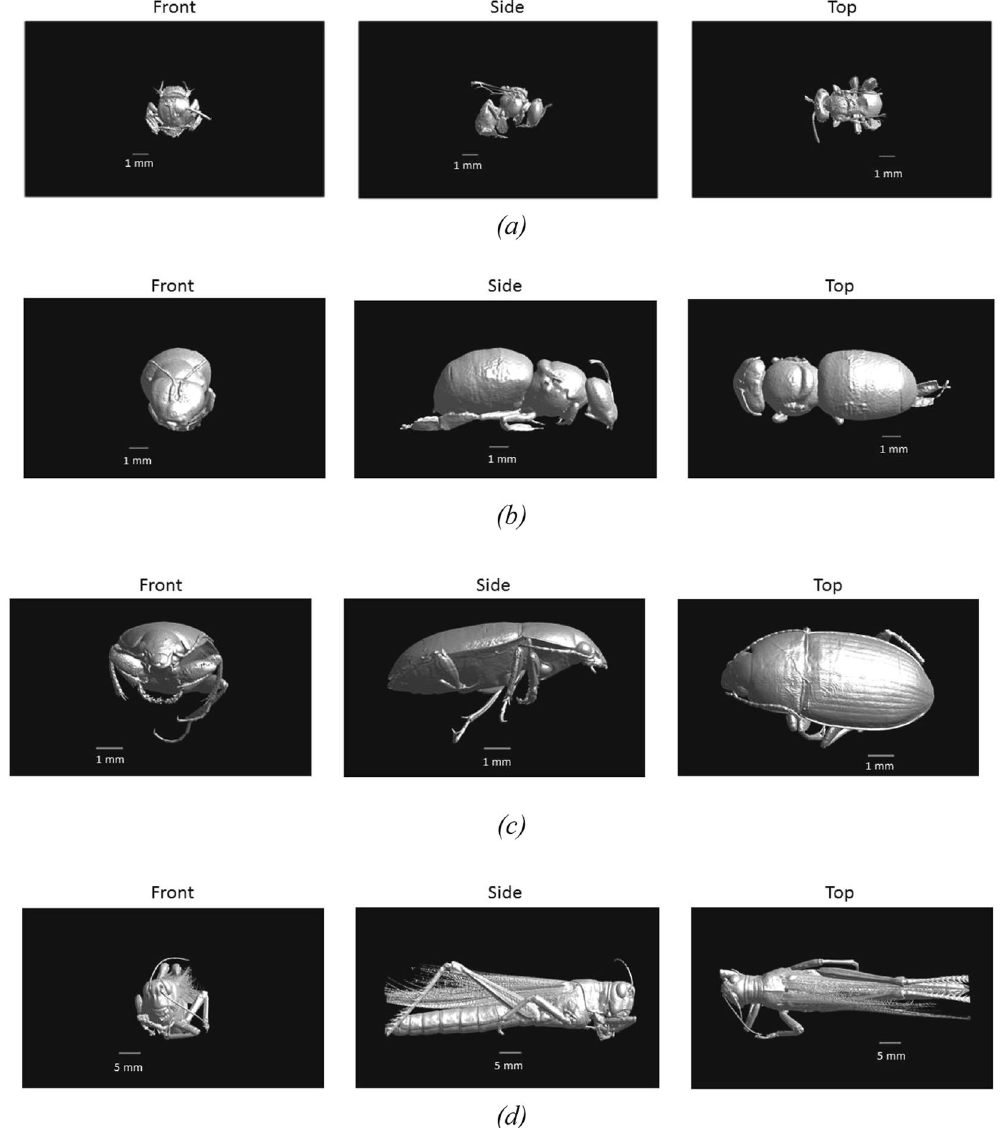
Figure 2. Frontal, side, and Top view of the four studied insects. ( a ) Australian Stingless Bee, ( b ) Western Honeybee, ( c ) Beetle, and ( d )